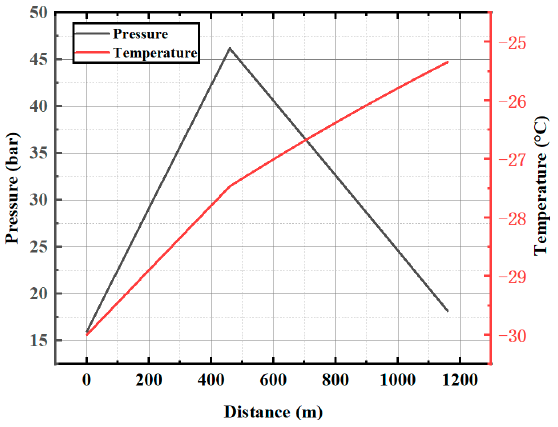
Figure 3. Pipeline transport simulation parameters of II020210 fully mechanized caving face in Yangchangwan Coal Mine.